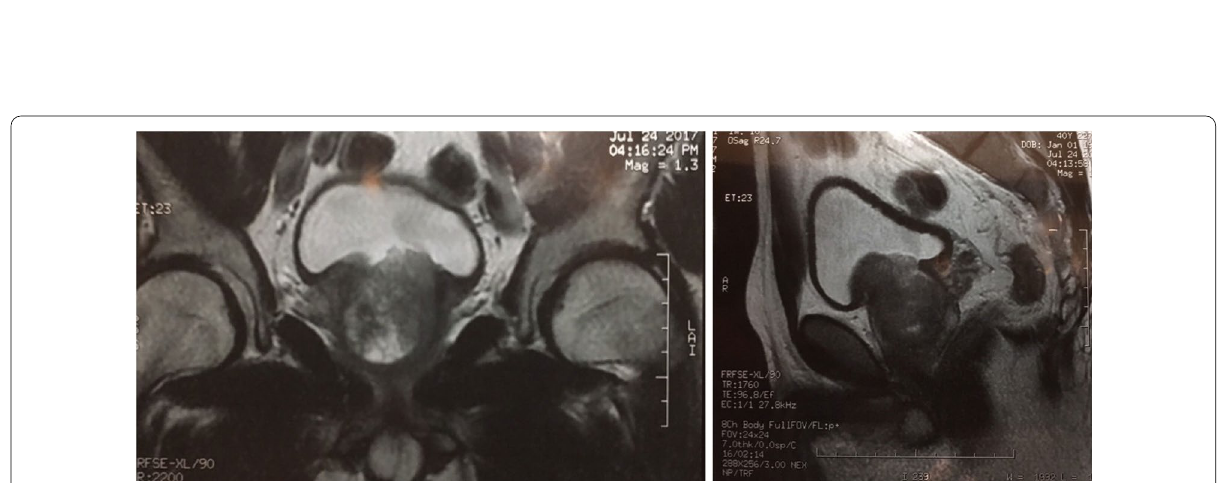
Fig. 2 Prostatic MRI showing the prostatic tumoral lesion with extra-capsular extension, right seminal vesicle invasion and a posterior bladder wall